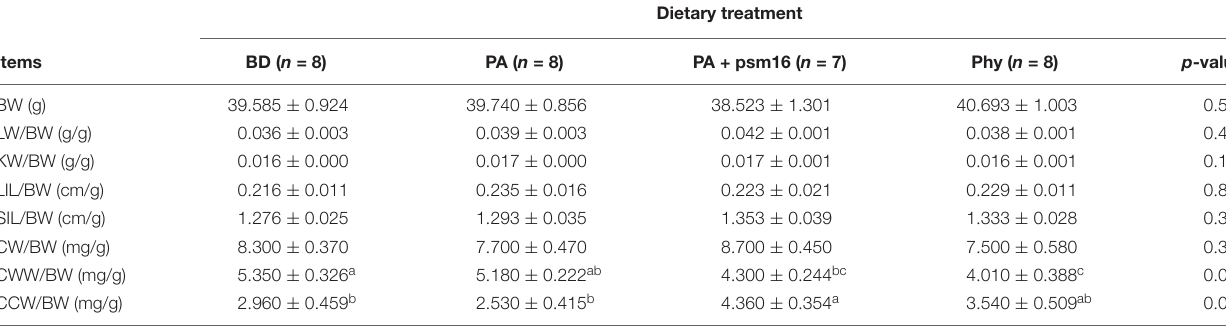
Dietary treatment